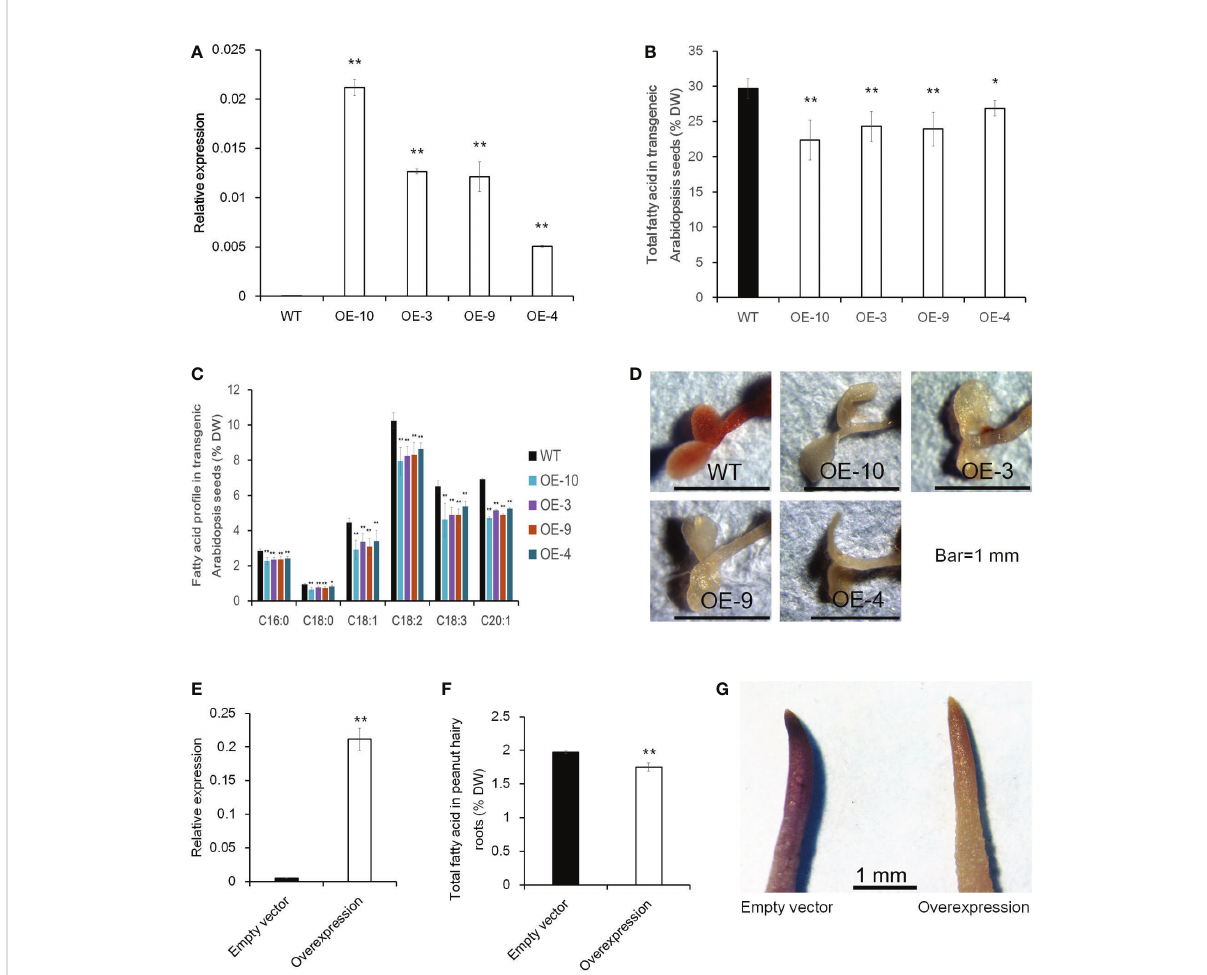
FIGURE 8 The effect of CTS overexpression on oil content in transgenic Arabidopsis and peanut hairy roots. (A) Expression level of CTS in Col-0 and transgenic Arabidopsis lines. Error bars indicated SD (n = 3). AtACTIN7 (AT5G09810) was used as the internal reference gene. (B) Total fatty acid content of mature seeds in Col-0 and transgenic Arabidopsis plants. Error bars indicated SD (n = 4). (C) Fatty acid pro fi le in Col-0 and transgenic Arabidopsis seeds. Error bars indicated SD (n = 4). The x-axis represented the species of fatty acid. (D) Fat red 7B staining of Col-0 and transgenic Arabidopsis plants. (E) Expression level of CTS in peanut transgenic hairy roots. Error bars indicated SD (n = 4). GAPDH (Morgante et al., 2011) was used as the internal reference gene. (F) Total fatty acid content in peanut transgenic hairy roots. Error bars indicated SD (n = 4). (G) Fat red 7B staining of peanut hairy roots. Student ’ s t -test was used for signi fi cance analysis. Asterisks indicated signi fi cant differences between transgenic plants with WT plants (empty vector) under the same treatment (* P < 0.05 and ** P < 0.01). CTS indicated acyl transporter ( Araip.H6S1B